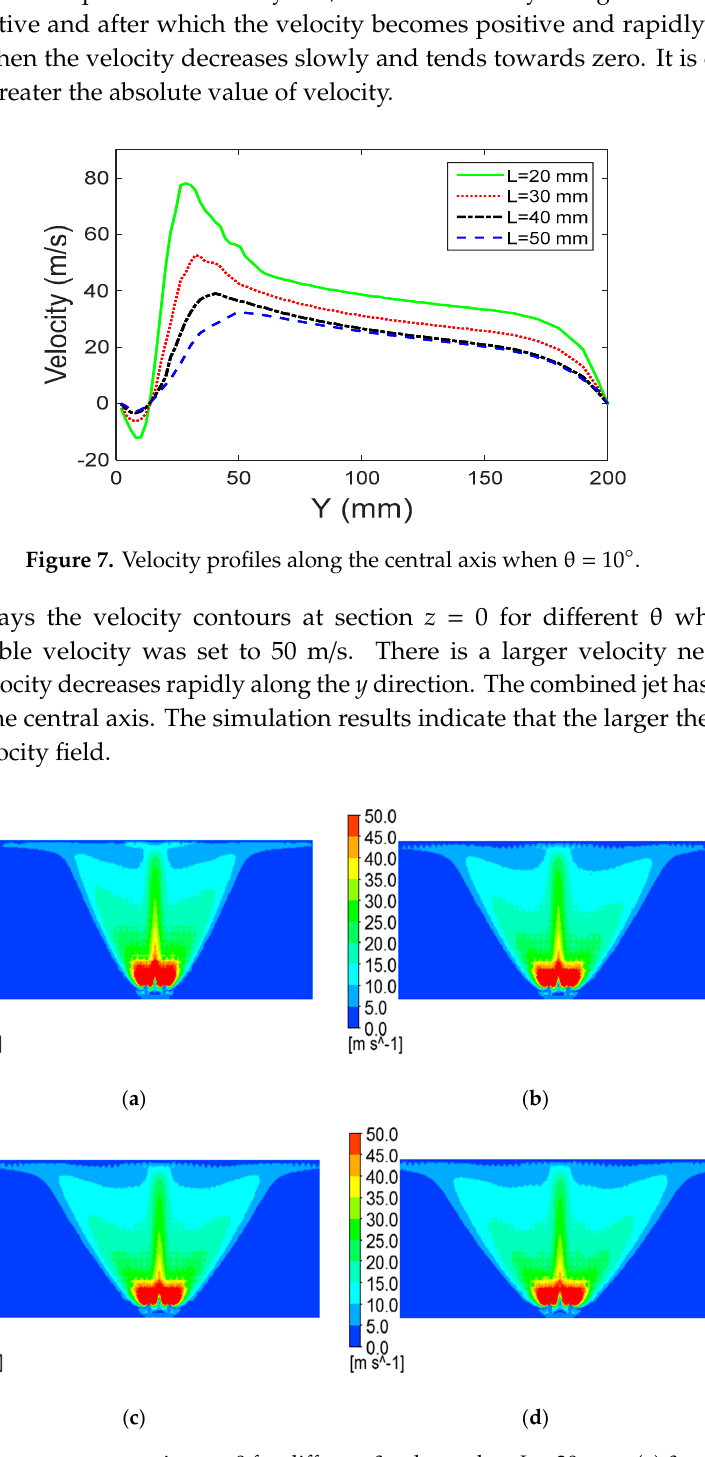
Figure 8. Velocity contours at section z = 0 for different θ values when L = 30 mm: ( a ) θ = 0°; ( b ) θ = 5°; ( c ) θ = 10°; ( d ) θ = 15°.